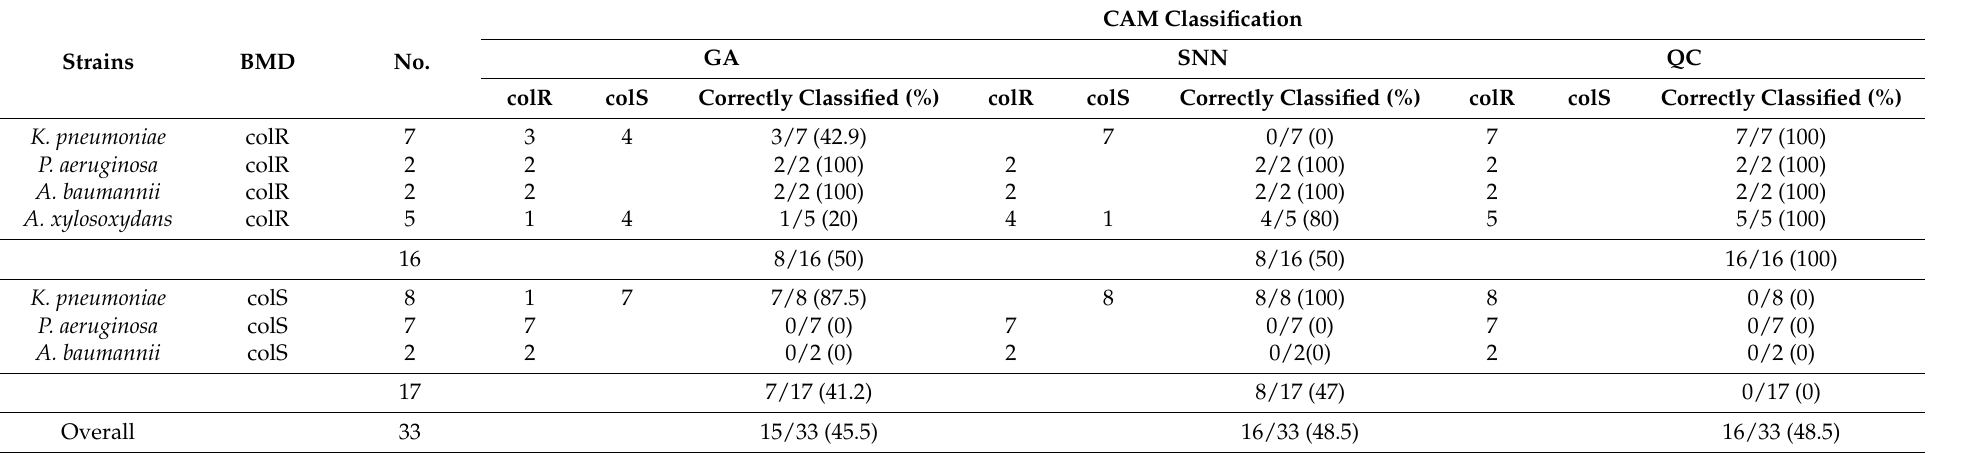
Table 3. Classification of strains other than E. coli by the 3 different classify algorithm models (CAMs). BMD Broth microdilution; GA Genetic Algorithm; SNN Supervised Neural Network; QC Quick Classifier; colR colistin-resistant; colS